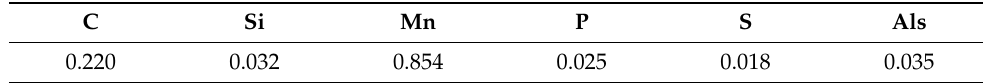
Table 1. Chemical composition of SWRCH22A steel,